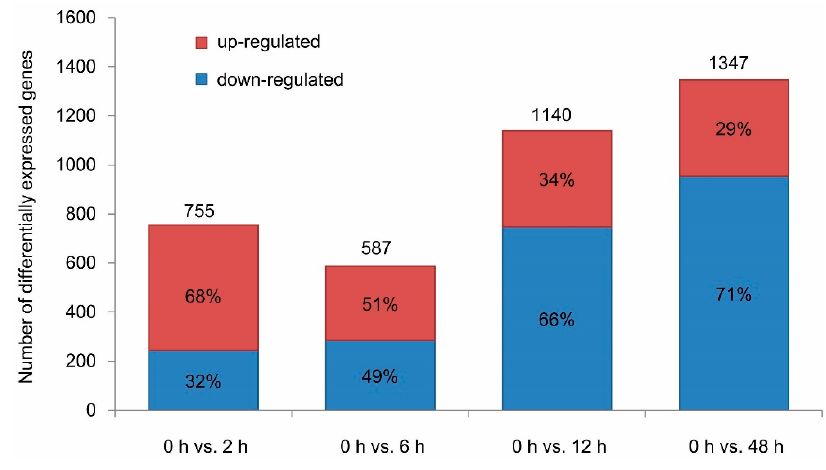
ff erentially expressed genes (DEGs) in virus-infected Figure 2. Differentially expressed genes ( DEGs) in virus-infected whiteflies. Figure 2. Di Figure 2. Differentially expressed genes ( DEGs) in virus-infected whiteflies.